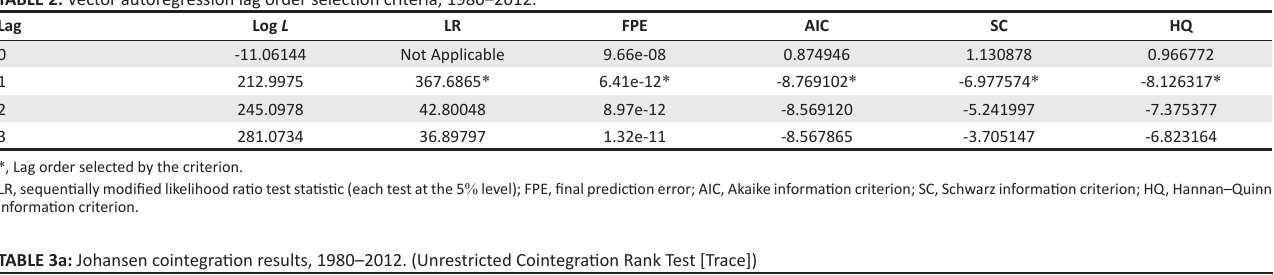
TABLE 3a: Johansen cointegration results, 1980–2012. (Unrestricted Cointegration Rank Test [Trace]) Hypothesised (Number of CE[s])